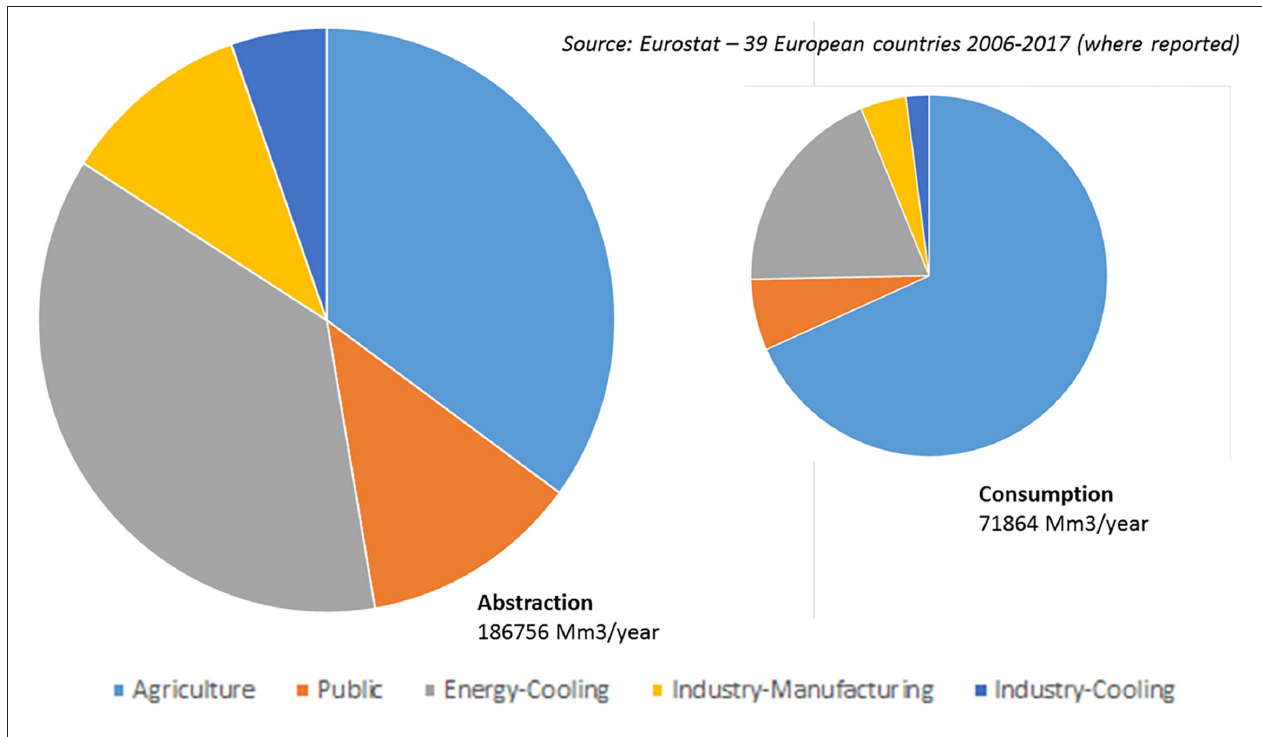
FIGURE 5 | Reported water abstractions (left, source Eurostat) and estimated net consumption.